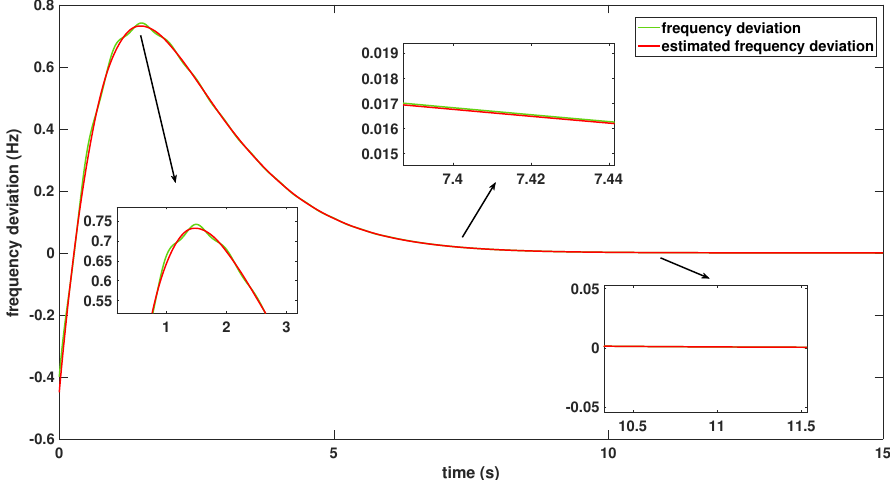
Figure 3. The evolution of the Bernoulli stochastic variables with α = 0.9, β = 0.9, and θ = 0.1.